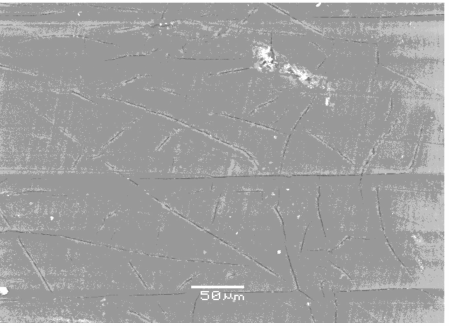
Figure 7. SEM image of the textolite material surface with clearly marked degradation effects at a high magnification of 300 times. A network of small cracks in the resin surface is